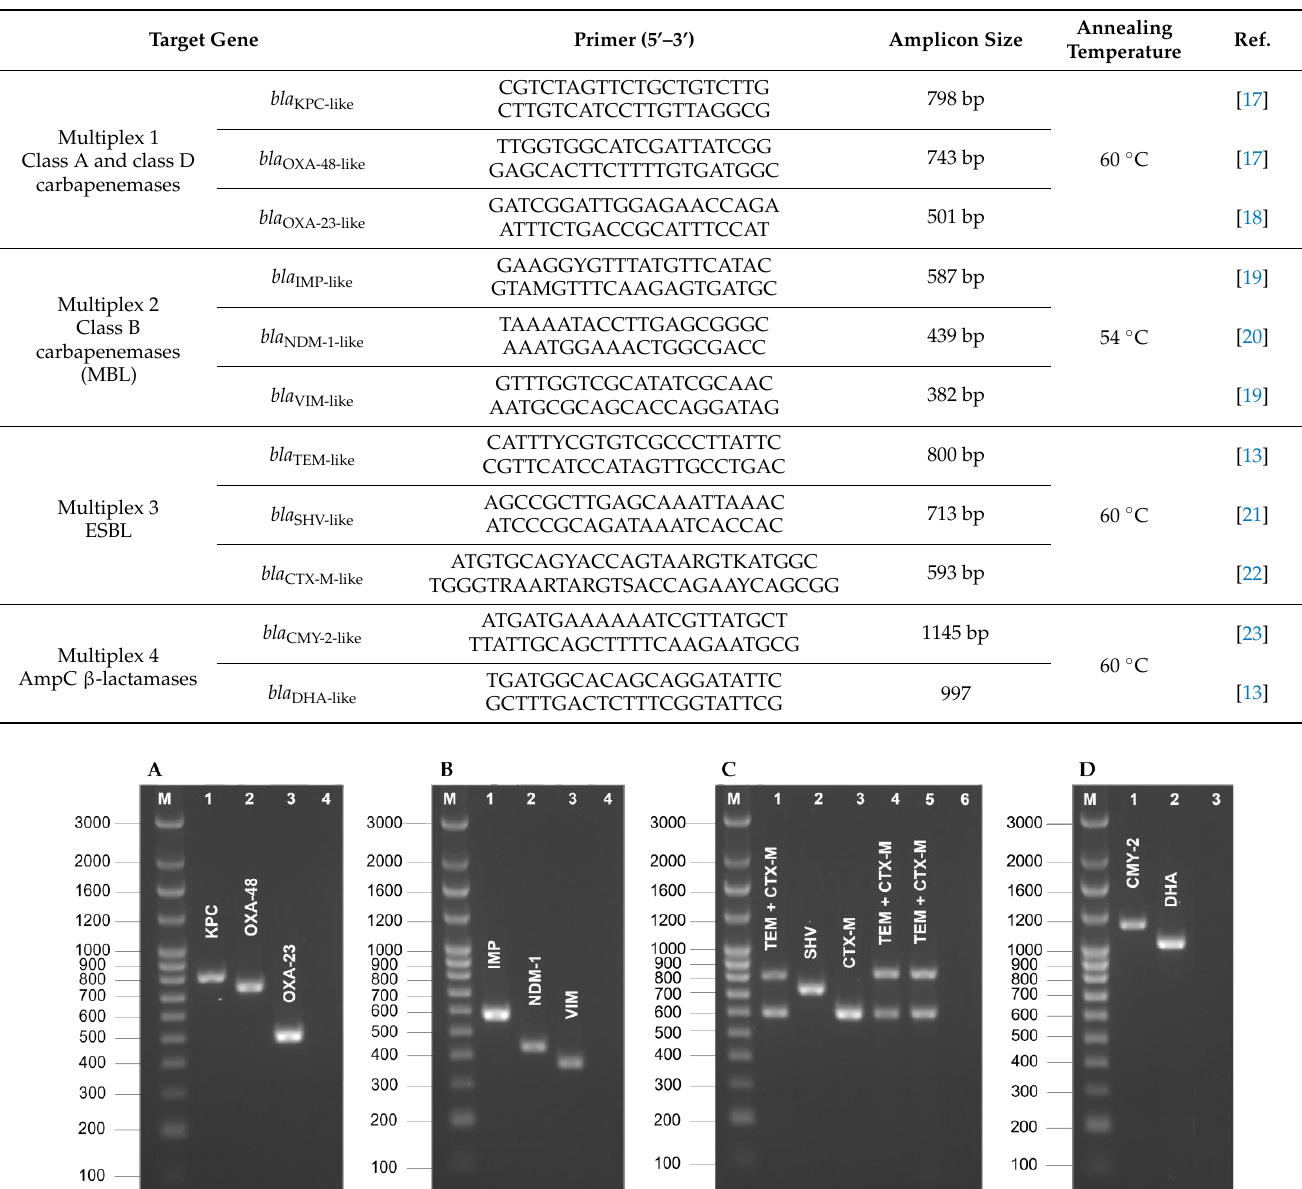
Table 2. Sequences of primers and conditions used for each multiplex PCR for the detection of resistance genes in the study.